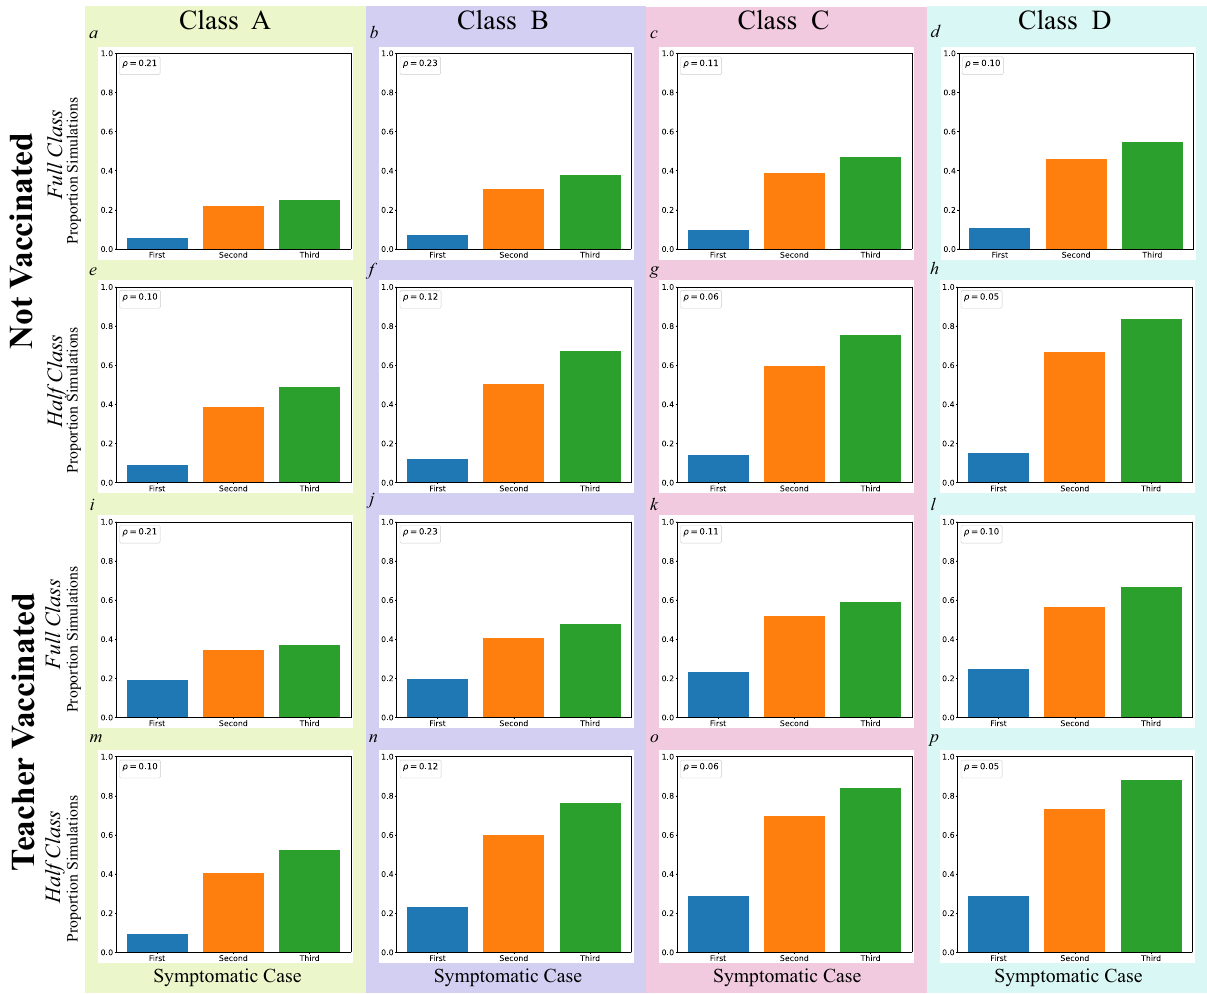
Figure 5. The proportion of simulations in which the first, second, and third symptomatic cases do not emerge in classes A–D. Teacher vaccinated and not vaccinated as well as full and half-sized class scenarios are presented. The horizontal axis indicates the nth symptomatic case. The vertical axes indicate the proportion of simulations, and ρ ’s in each legend represent the classroom densities in the unit of people per m 2